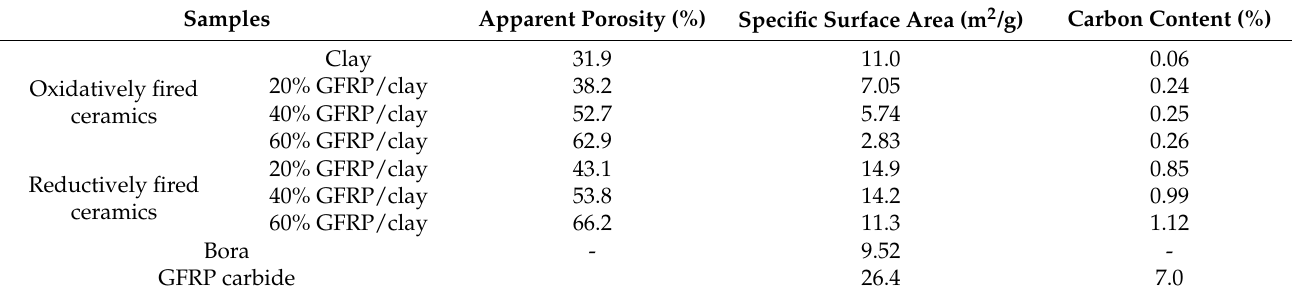
Table 3. Apparent porosity, specific surface area and carbon content of the